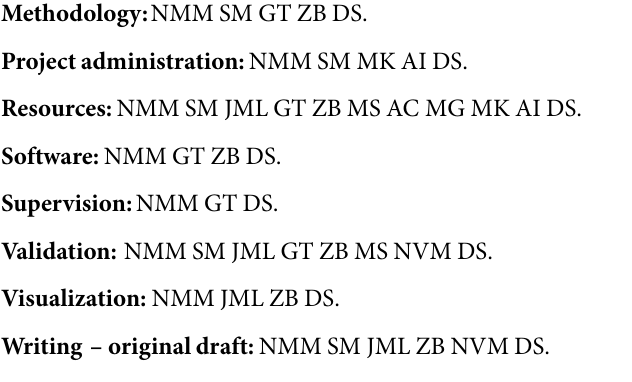
S1 Table. Search Strategy for Scopus Database. S2 Table. Individual study assessment for risk of bias according to RoBANS (Risk-of-bias assessment tool for